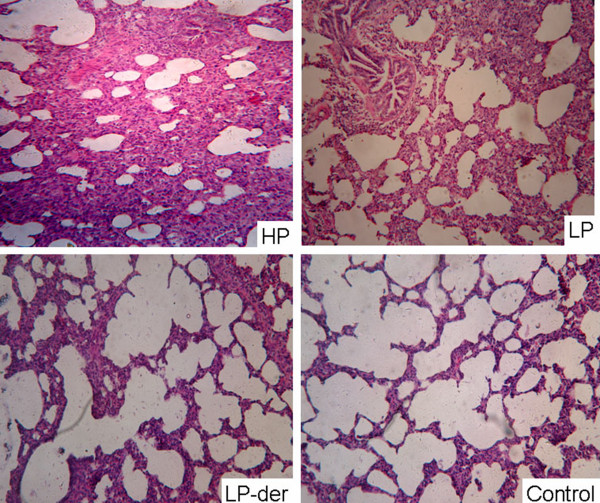
Pathological examination of lung tissues of pigs from groups HP, LP, LP-der PRRSV and the control group at 15 d.p.i. The tissues were stained with hematoxylin and eosin (magnification, x200).